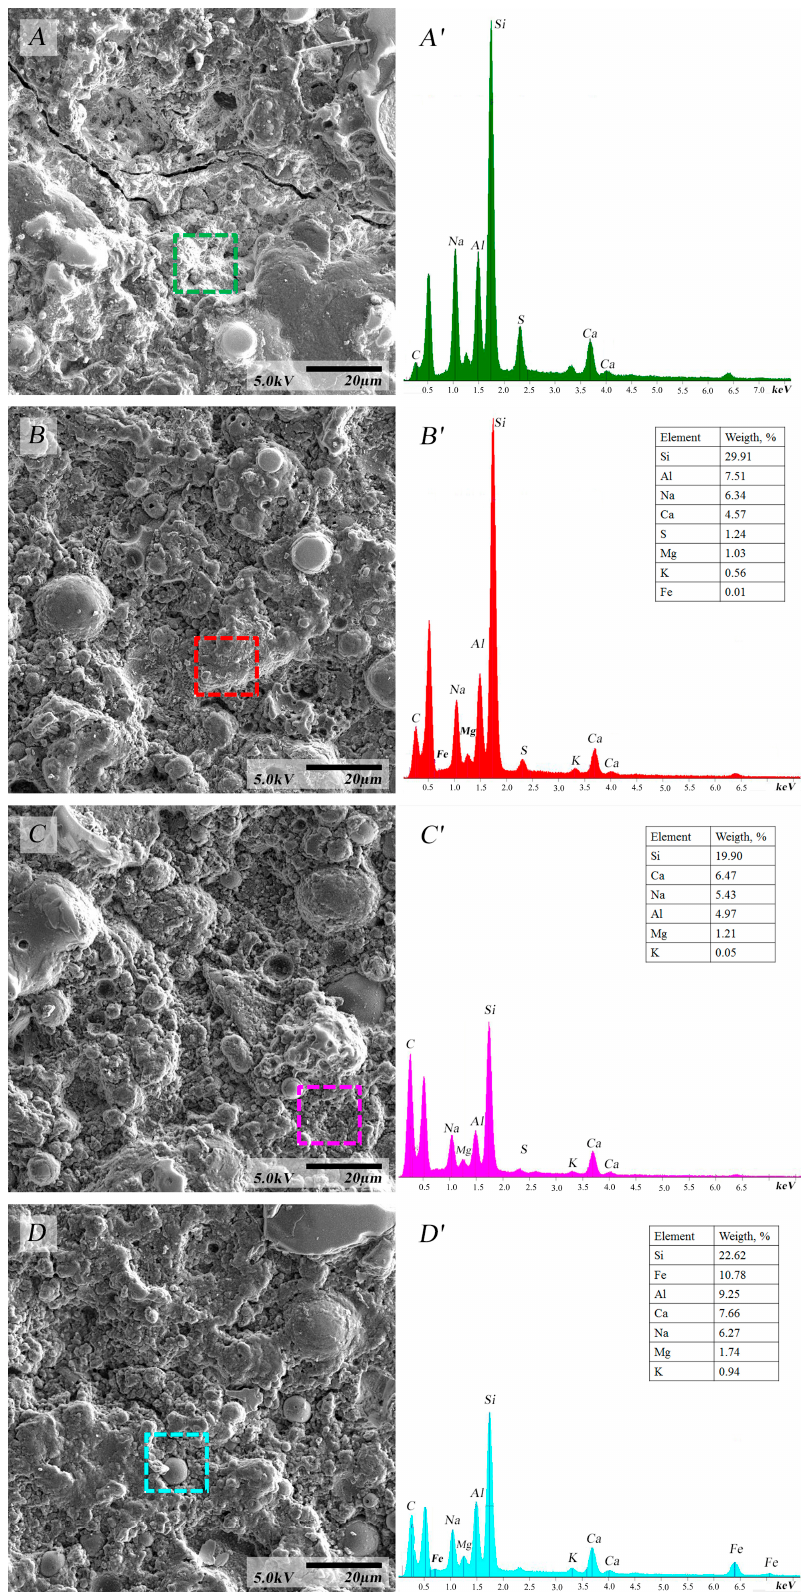
Figure 6. SEM micrographs and the corresponding EDS spectra of the raw and milled fly-ash-based geopolymers after 7 days of curing. ( A , A’ ) Raw. ( B , B’ ) Ball-milled 30 min. ( C , C’ ) Ball-milled 60 min. ( D , D’ ) A tt rition-milled.